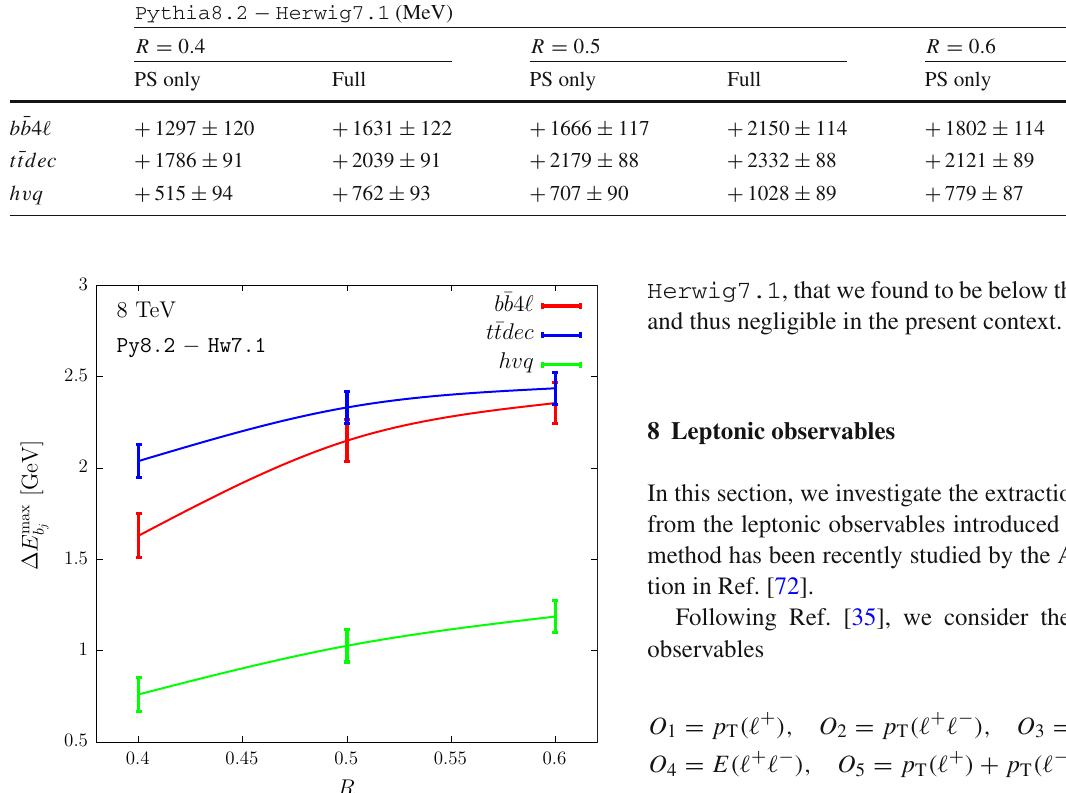
Table 16 Theoretical uncertainties for the E b peak j position obtained with the three generators showered with Pythia8.2 . The last column reports the statistical uncertainty of our results Table 17 E b peak position j obtained with the b ¯ b 4 (cid:4) generator showered with Pythia8.2 , for three choices of the jet radius. The differences with the t ¯ tdec and the h v q generators are also shown Table 18 Differences in the E b peak position between the Pythia8.2 and the Herwig7.1 showers applied to the three generators for three j choices of the jet radius. The results at the NLO+PS level (PS only) are also shown Pythia8.2 − Herwig7.1 (MeV)